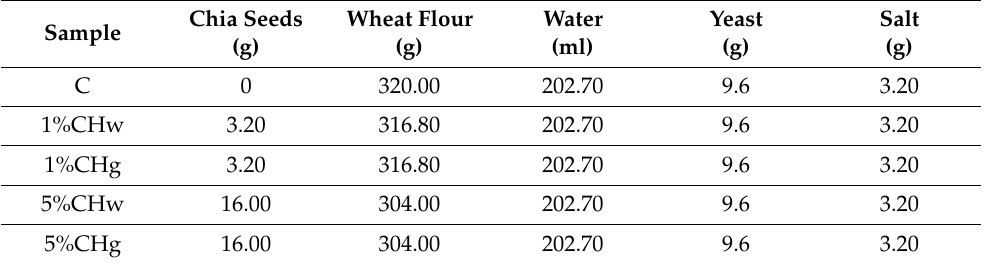
Table 1. Recipes used for the production of wheat bread and wheat breads with chia seeds by the single-phase